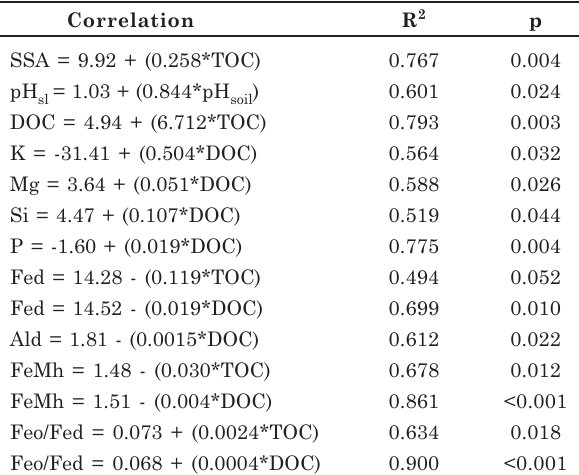
Table 3. Correlations (n = 8) between physical, chemical and mineralogical properties of two layers of a Rhodic Paleudult under four land use and management systems